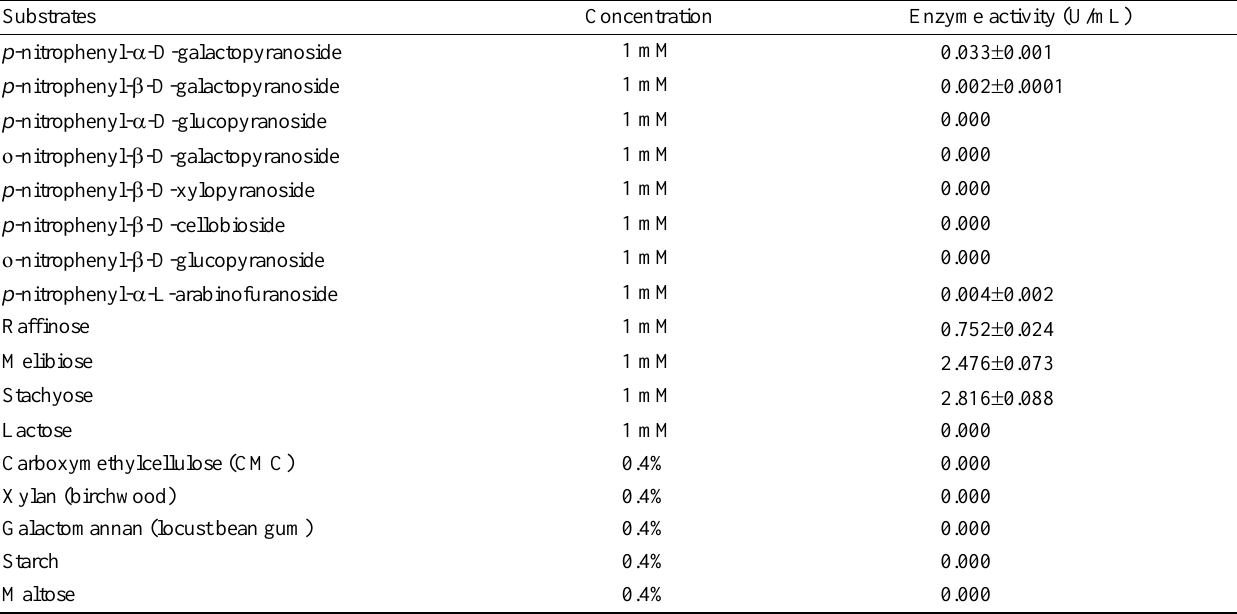
Table 2. Substrate specificity of LX-20  -galactosidase